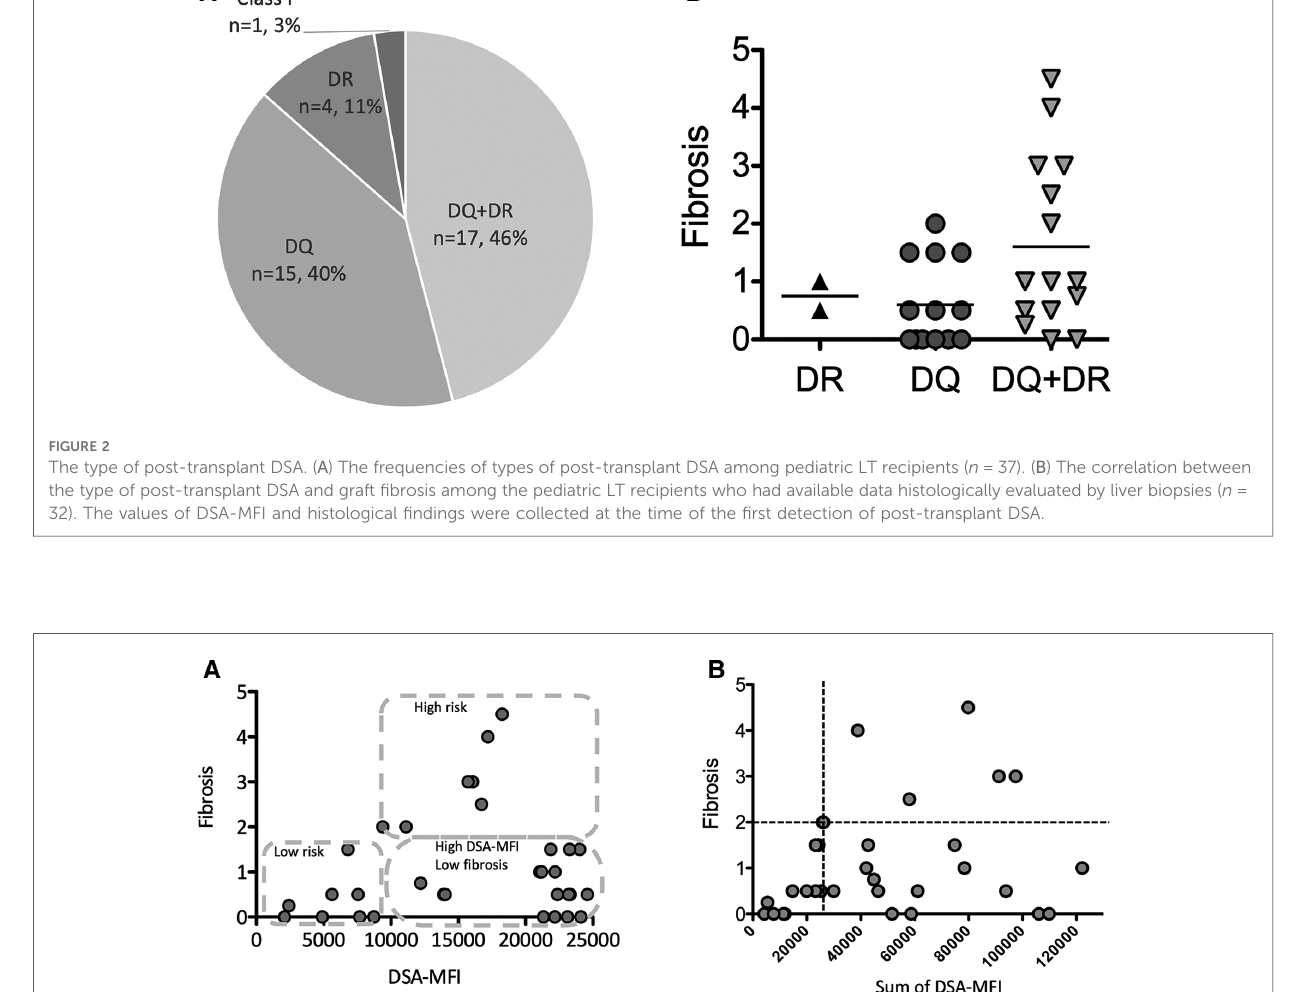
DSA-MFI and advanced graft fi brosis ( r = 0.65, Figure 3A ). All